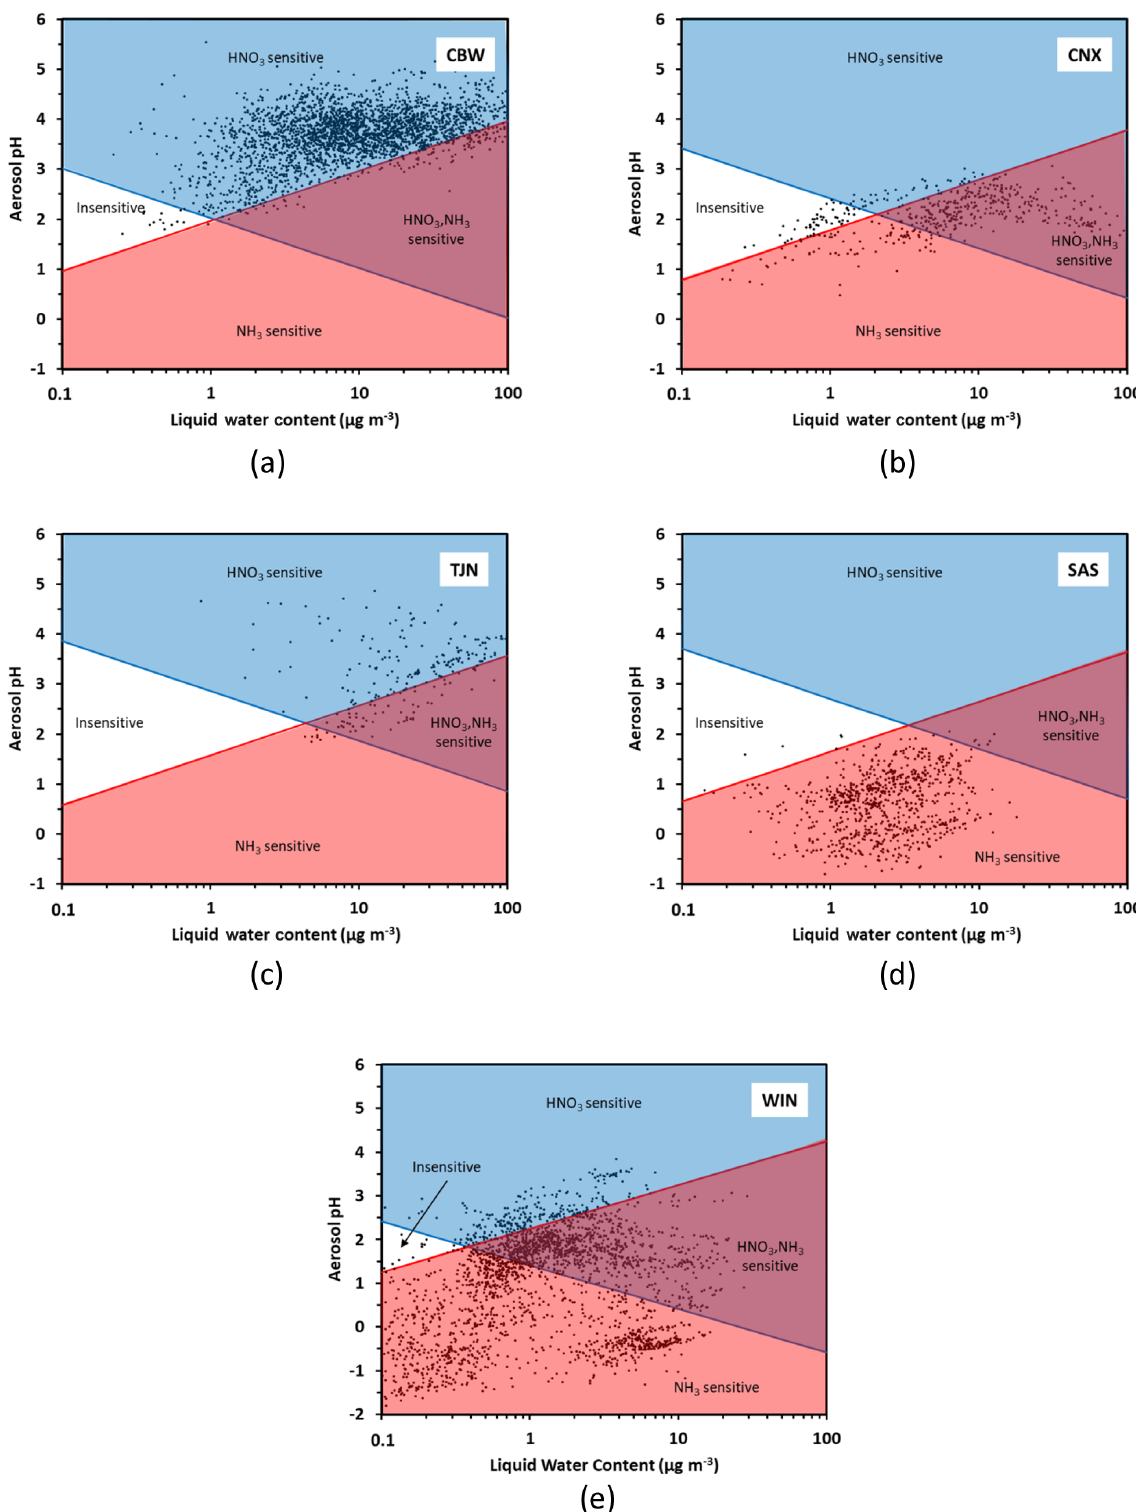
Figure 5. Chemical domains of sensitivity of aerosol to NH 3 and NO x emissions for five regions examined: (a) Cabauw – CBW, (b) CalNex – CNX, (c) Tianjin – TJN, (d) SOAS – SAS, and (e) E United States (WIN). Average composition, temperature, and humidity along with their variations (expressed by their standard deviation) are provided in Table